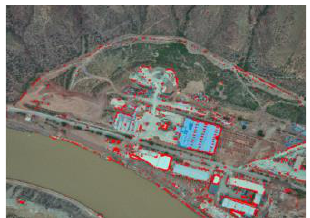
Figure 2. Interest point extraction by original FAST detector